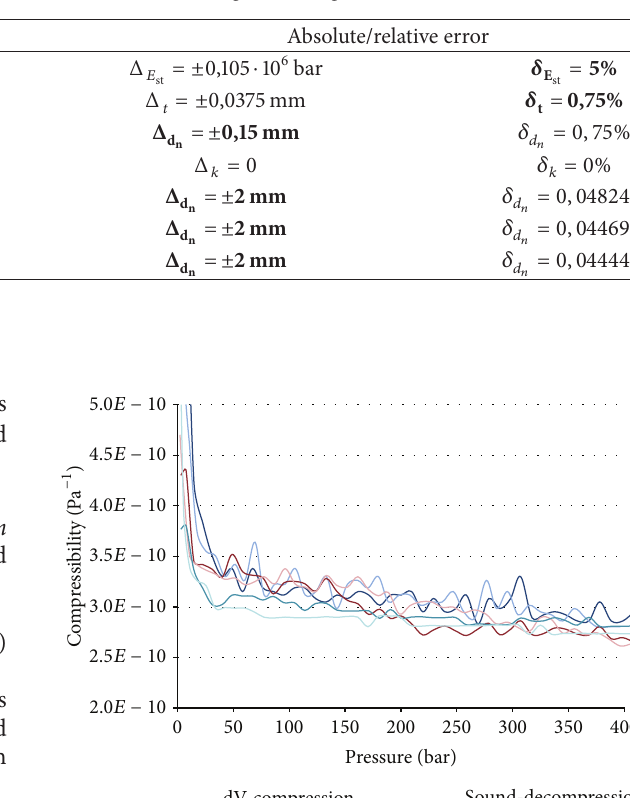
Table 6: Absolute and relative errors of variables that were constant throughout a single measurement.